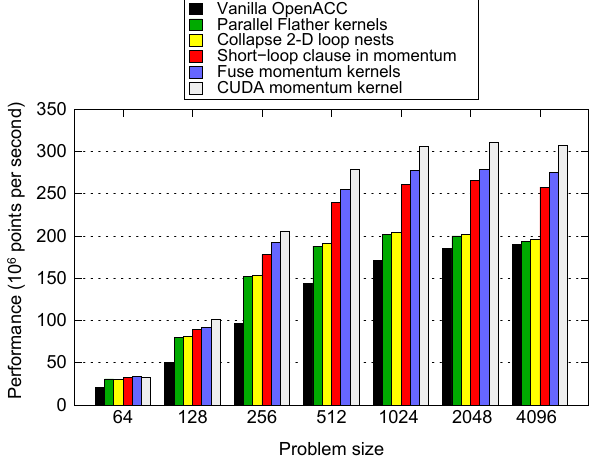
Figure 11. Performance of the PSyKAl (OpenACC) and CUDA GPU implementations of NEMOLite2D. Optimizations are added to the code in an incremental fashion. The performance for the Ope- nACC version of the original code is not shown since it is identical to that of the vanilla PSyKAl version.